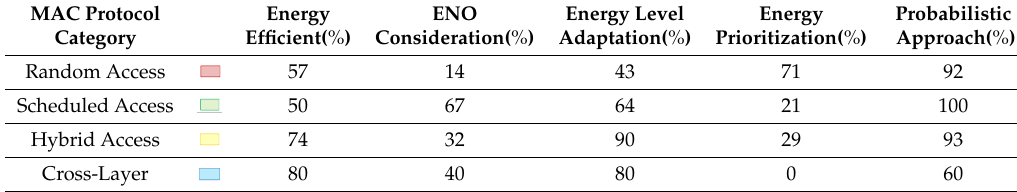
Figure 6. Category-based comparison of energy-related parameters in energy harvesting MAC protocols.